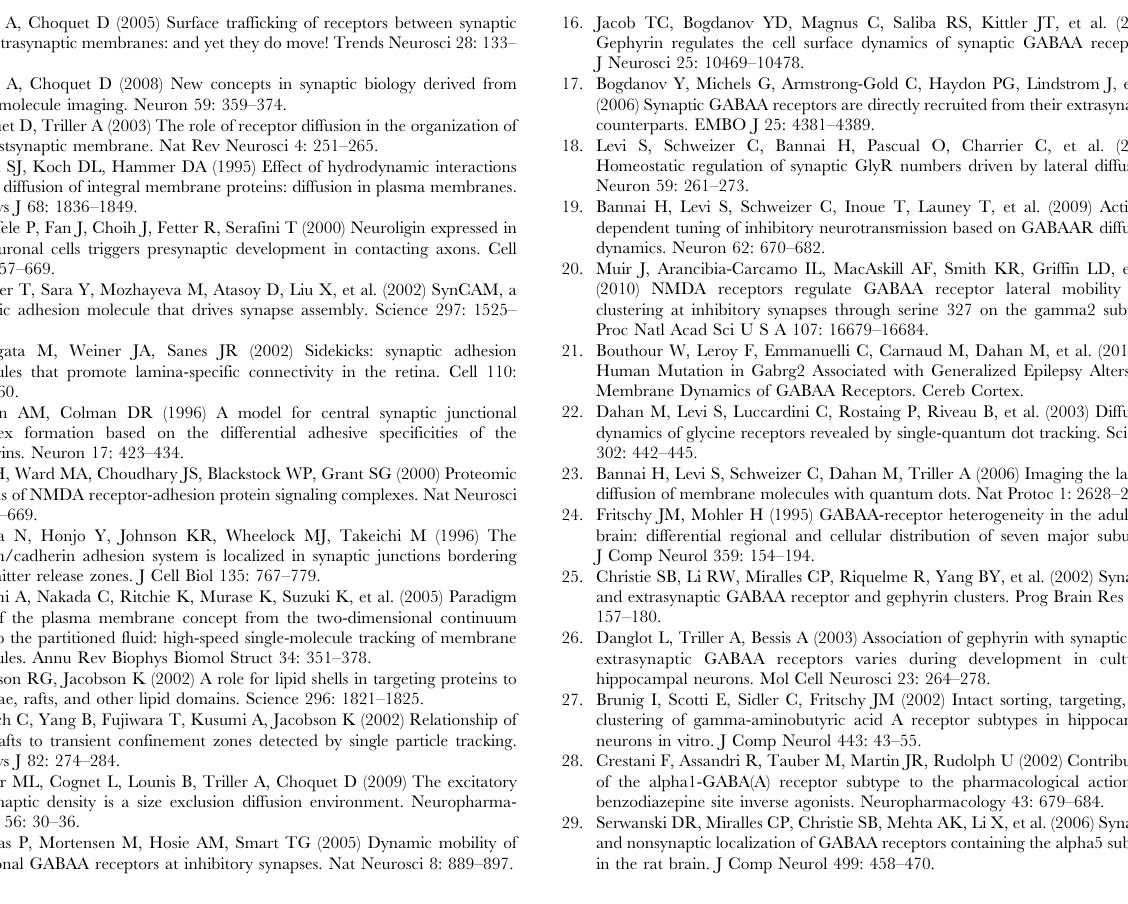
Figure S2 Diffusion properties of GluA2 in excitatory and inhibitory synapses. Instantaneous diffusion coefficients (A, C) and MSDs as a function of time (B, D) for GluA2 trajectories exemplified in Fig. 5 A at excitatory synapses (A–B) and at inhibitory synapses (C–D). Color code: red, green and black, QD trajectories at excitatory synapses, inhibitory synapses and at extrasynaptic site,